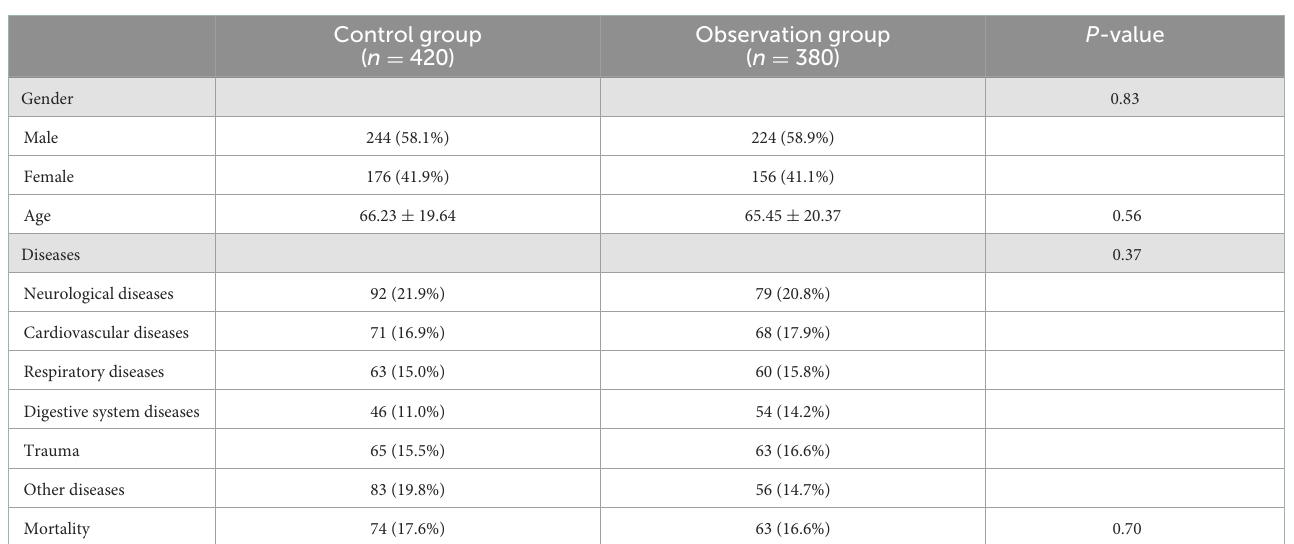
TABLE 3 Baseline characteristics of